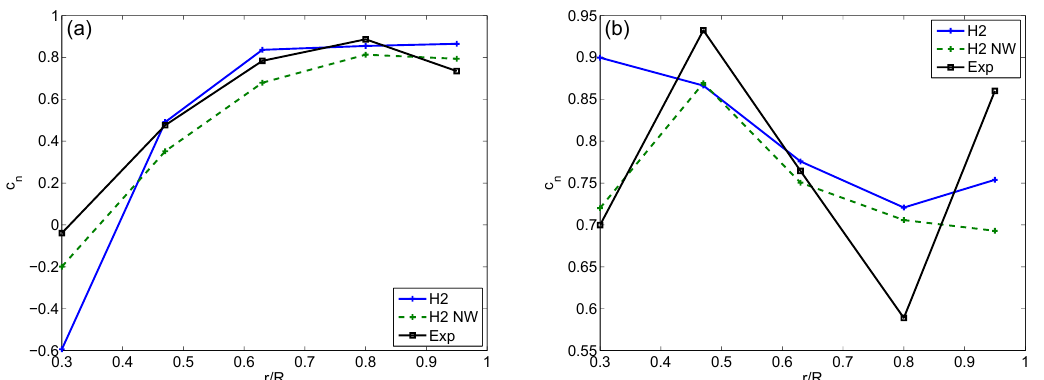
Figure 4. Radial distribution of normal force coefficients at 3.5 (a) and 18.2 (b) degrees geometric AOA at 47% blade radius. Results from HAWC2 (denoted H2) and HAWC2 including the extended near-wake model presented in this paper (H2 NW) are compared to